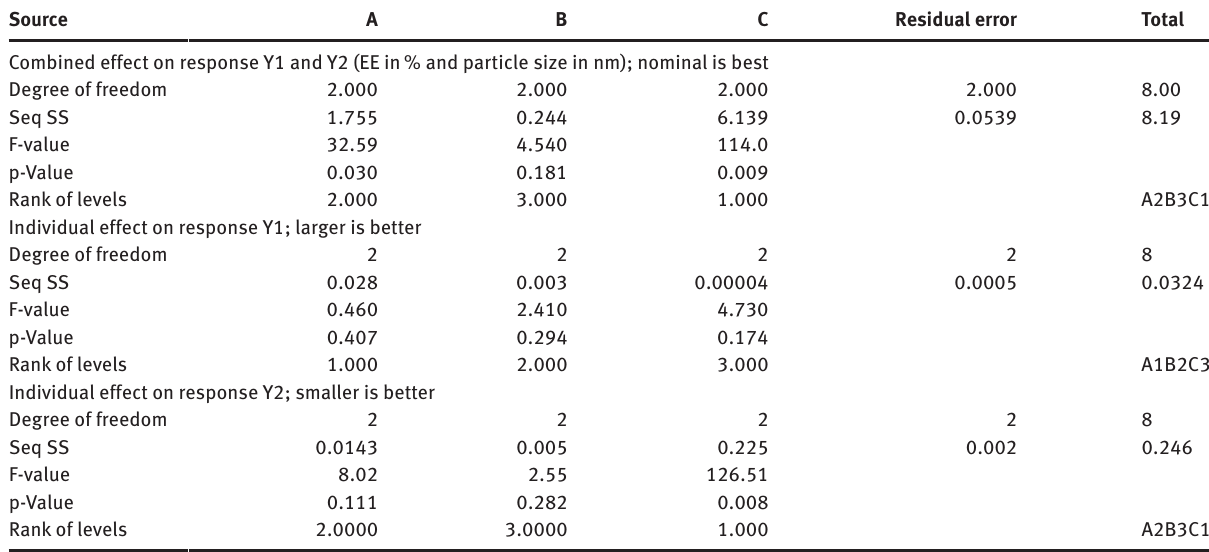
Table 4: Analysis of variance